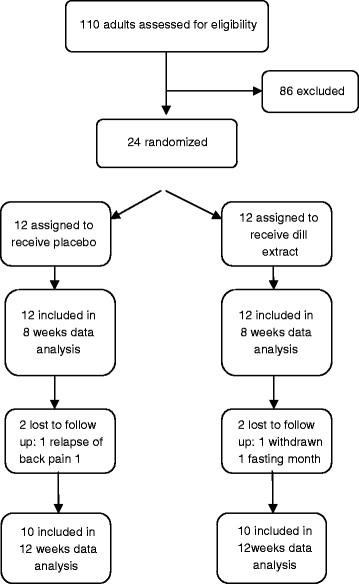
Flow of the trial.